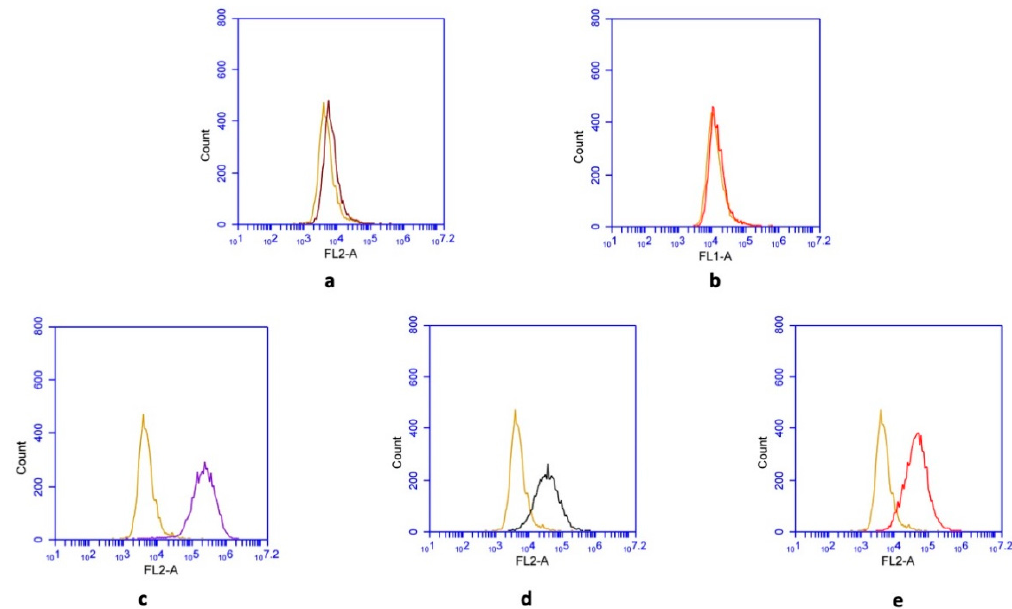
Figure 1. Cell surface marker expression profile of mesenchymal stem cells (MSCs). Flow cytometric analysis demonstrating that obtained MSCs were negative for ( a ) CD11b and ( b ) CD45, while they were positive for the antigens ( c ) CD73, ( d ) CD90, and ( e ) CD105. Only representative examples are shown here.